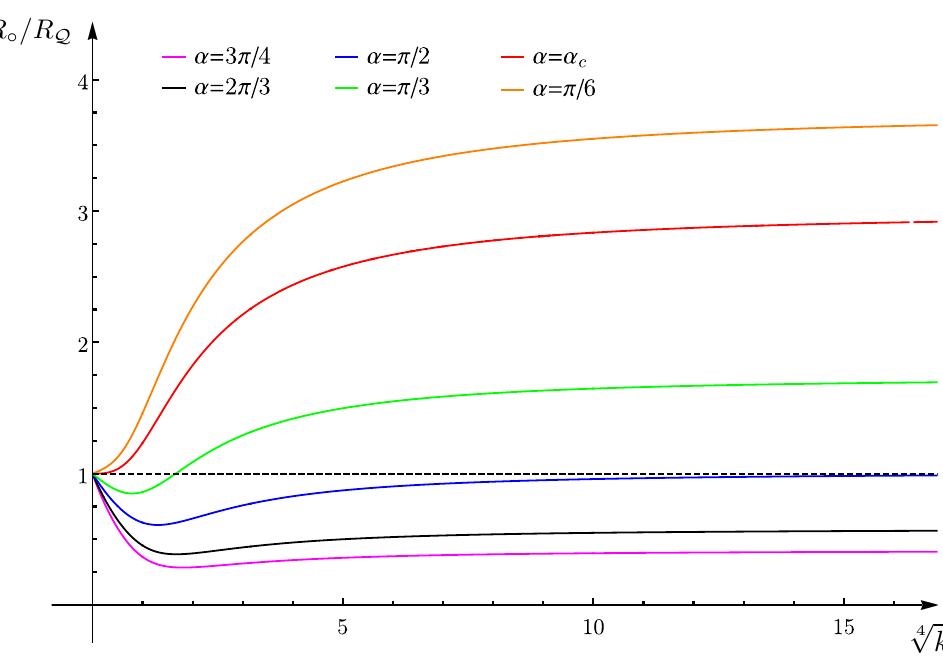
p as a function of 4 k from (4.9) for di(cid:11)erent values A